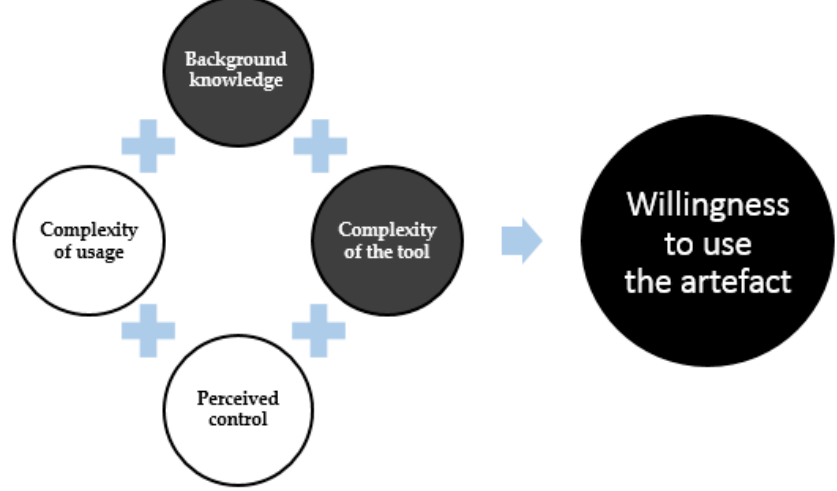
Figure 4. High student willingness to use the artefact as influenced by a similar level of background knowledge and perceived control.